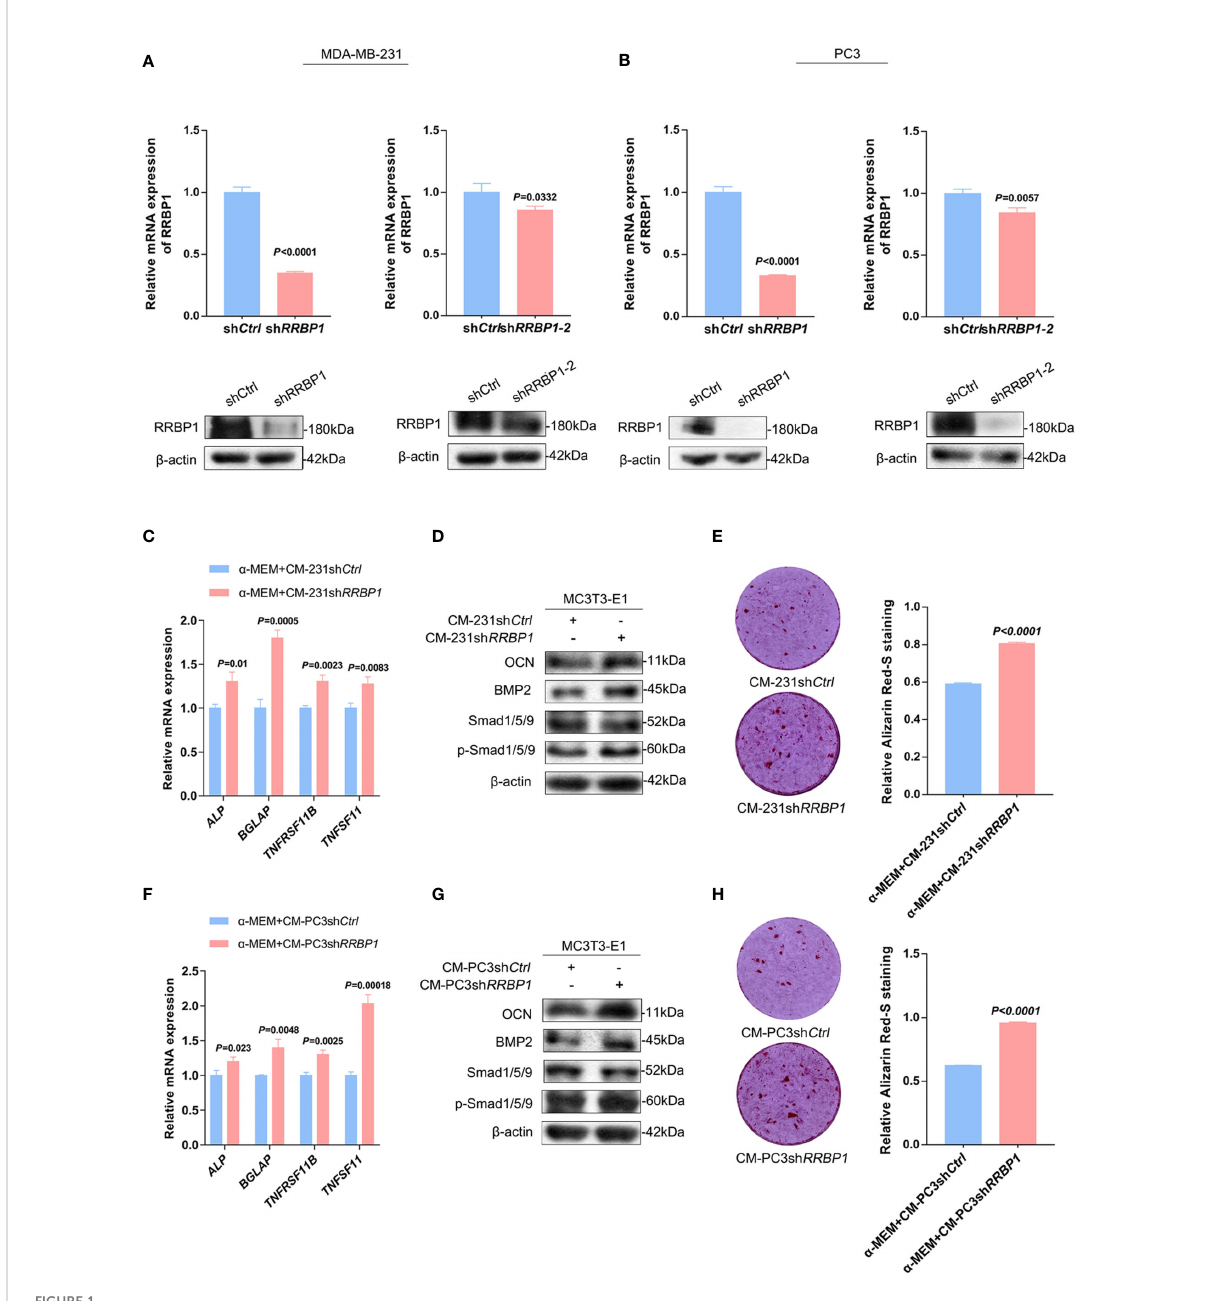
FIGURE 1 The effect of CM from MDA-MB-231 or PC3 cells transduced with sh RRBP1 on the osteoblastic phenotype expression in MC3T3-E1 cells. (A) MDA-MB-231 cells were transduced with sh RRBP1 or sh RRBP1- 2 vectors, respectively. The relative mRNA and protein levels of RRBP1 were measured via qPCR and western blotting assays, respectively. (B) PC3 cells were transduced with sh RRBP1 or sh RRBP1- 2 vectors, respectively. The relative mRNA and protein levels of RRBP1 were measured via qPCR and western blotting assays, respectively. (C, D) MC3T3-E1 cells were cultured in a -MEM+CM-231sh Ctrl and a -MEM+CM-231sh RRBP1 for 7 d, respectively. Relative mRNA levels of ALP, BGLAP, TNFRSF11B , and TNFSF11 were measured via qPCR assay (C) . The protein levels of OCN, BMP2, Smad1/5/9, p-Smad1/5/9, and b -actin were measured via western blotting analysis (D) . (E) MC3T3-E1 cells were cultured in a -MEM+CM-231 sh Ctrl and a -MEM+CM-231sh RRBP1 for 28 d, respectively, followed by ARS staining and evaluation of mineralization. (F, G) MC3T3-E1 cells were cultured in a -MEM+CM-PC3sh Ctrl and a -MEM+CM- PC3sh RRBP1 for 7 d, respectively. Relative mRNA levels of ALP, BGLAP, TNFRSF11B , and TNFSF11 were measured via qPCR assay (F) . The protein levels of OCN, BMP2, Smad1/5/9, p-Smad1/5/9, and b -actin were measured via western blotting analysis (G) . (H) MC3T3-E1 cells were cultured in a -MEM+CM-PC3sh Ctrl and a -MEM+CM-PC3sh RRBP1 for 28 d, respectively, followed by ARS staining and evaluation of mineralization. The data are representative of three independent